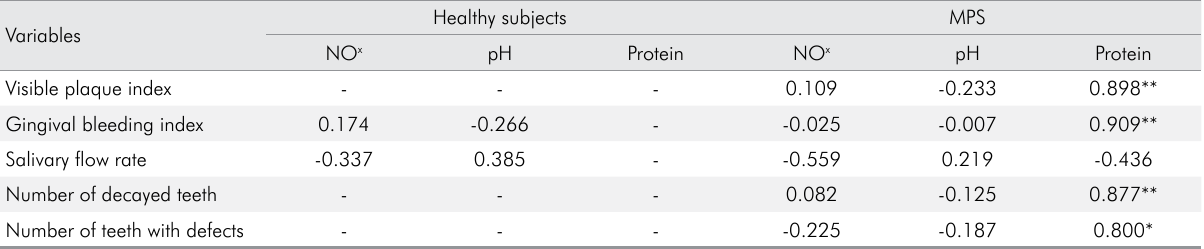
Table 2. Spearman’s correlations coefficient between the Clinical/Biochemical parameters and NO X levels in saliva (n = 20).